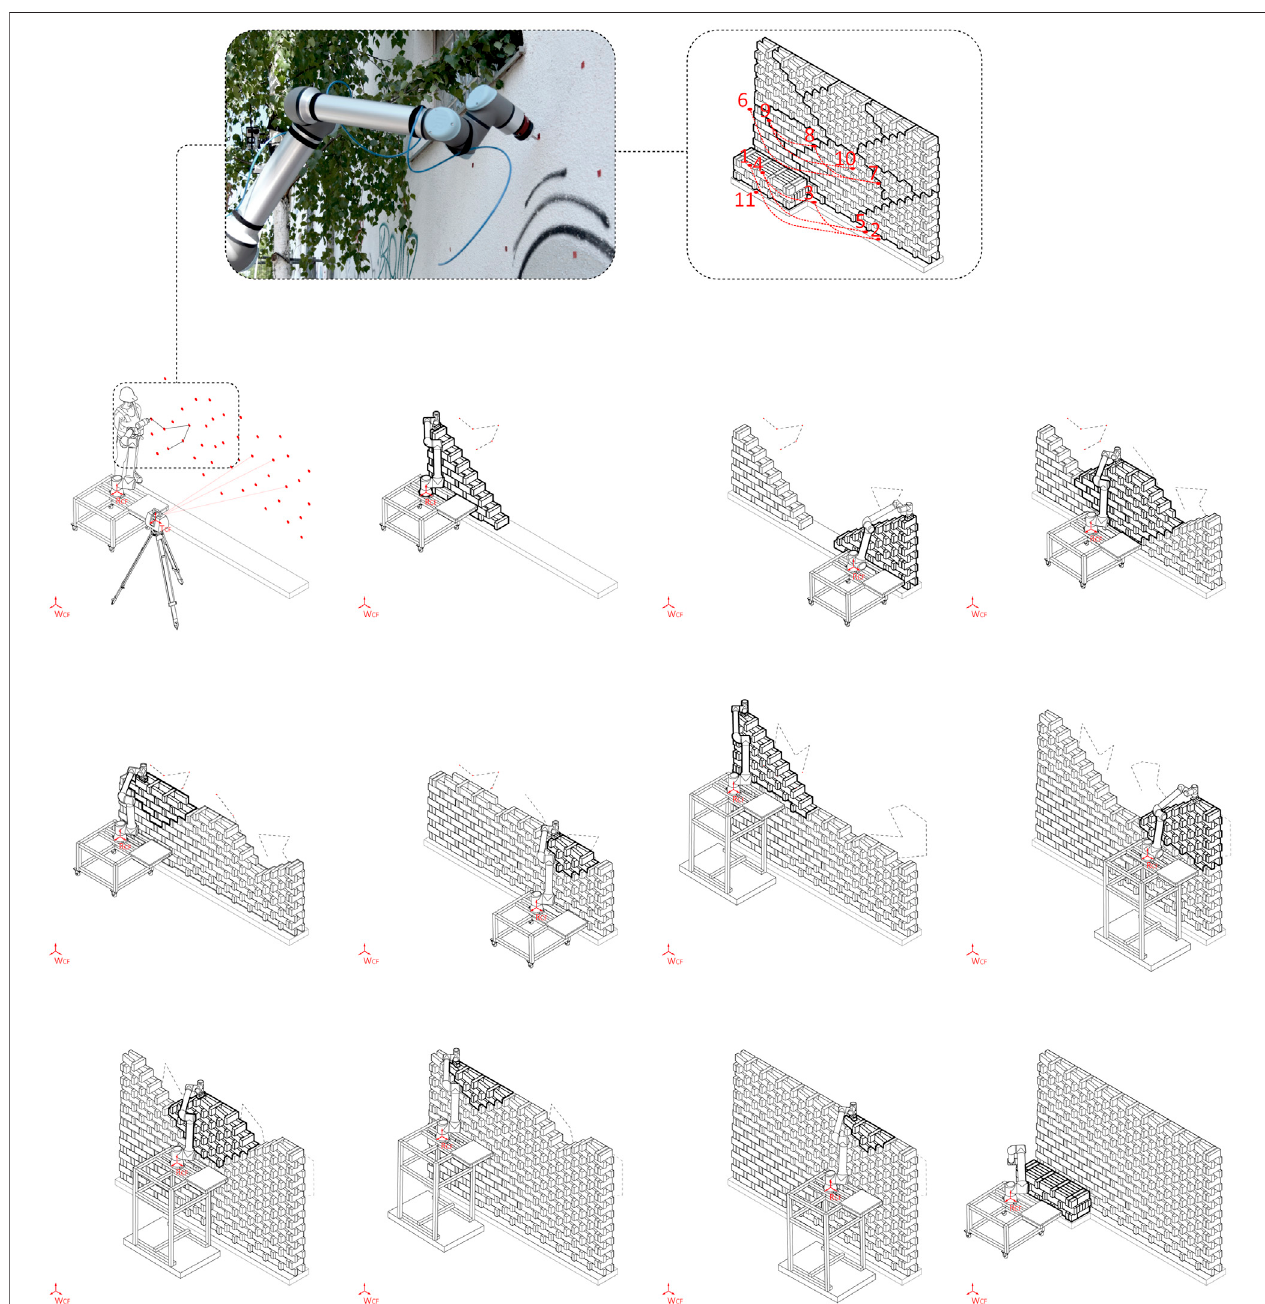
FIGURE9| Thecollaborativerobotwaslocalizedbyrecordingarangeofpointswiththerobotarmthathadpreviouslybeendigitizedbyarobotictotalstation. This localization procedure was carried out at each of the ten subsequent robot locations during construction.